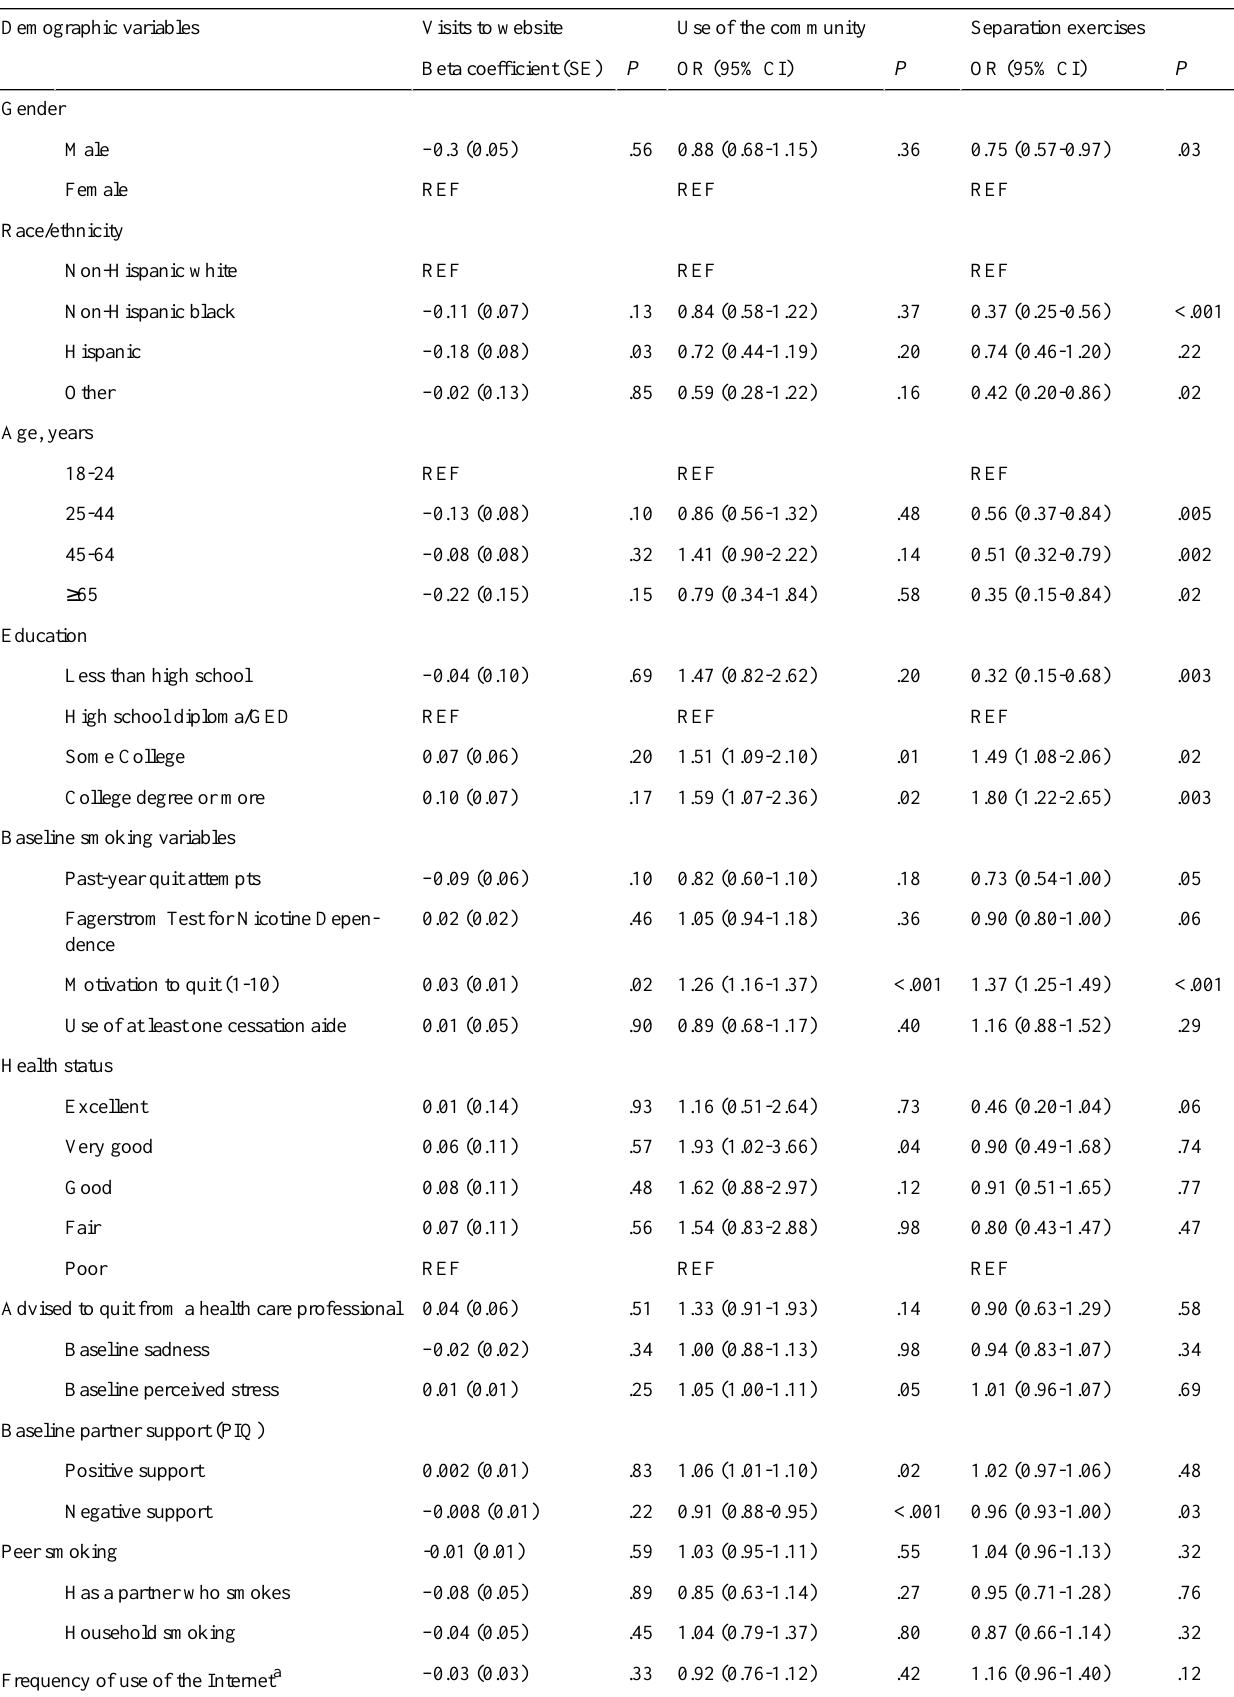
Table 4. Demographic characteristics and smoking behavior with use of BecomeAnEX.org website and its associated features (unweighted).